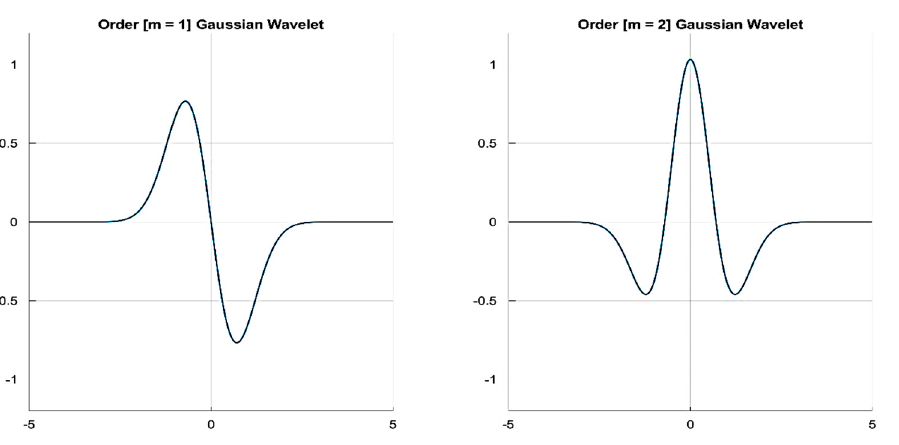
Figure 5. First and second order derivatives of Gaussian wavelets as examples of odd and even Gaussian wavelets.